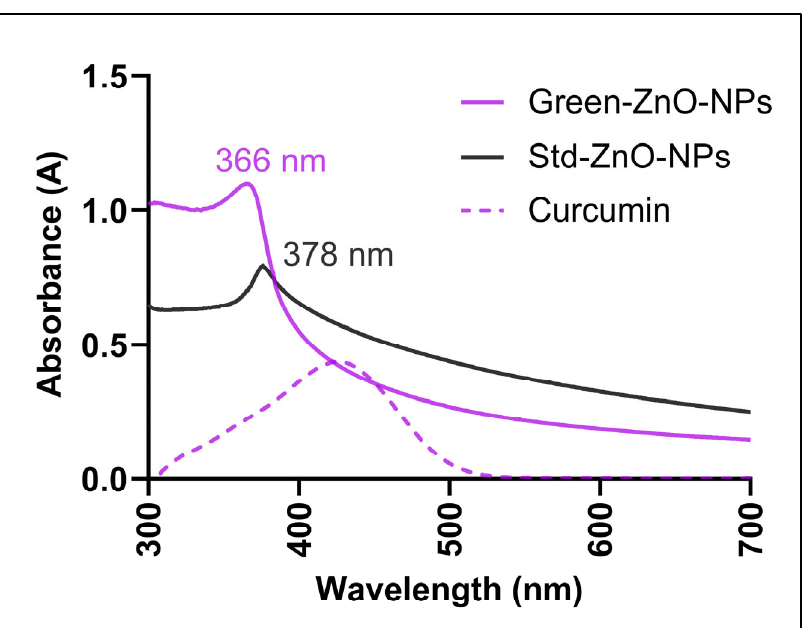
Figure 2. UV ‐ Vis absorption spectra of the aqueous suspension of Green ‐ ZnO ‐ NPs (100 μ g/mL), the Figure 2. UV-Vis absorption spectra of the aqueous suspension of Green-ZnO-NPs (100 µ g/mL), aqueous suspension of Std ‐ ZnO ‐ NPs (100 μ g/mL), and the ethanolic solution of curcumin (10 the aqueous suspension of Std-ZnO-NPs (100 µ g/mL), and the ethanolic solution of curcumin μ g/mL). (10 µ